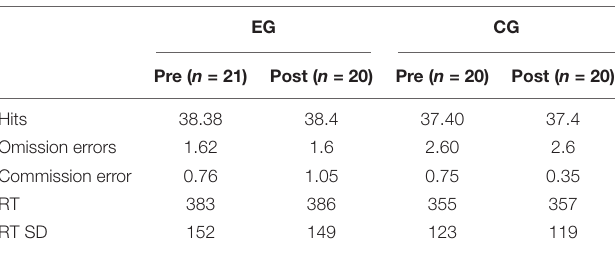
TABLE 1 | Descriptive data for behavioral